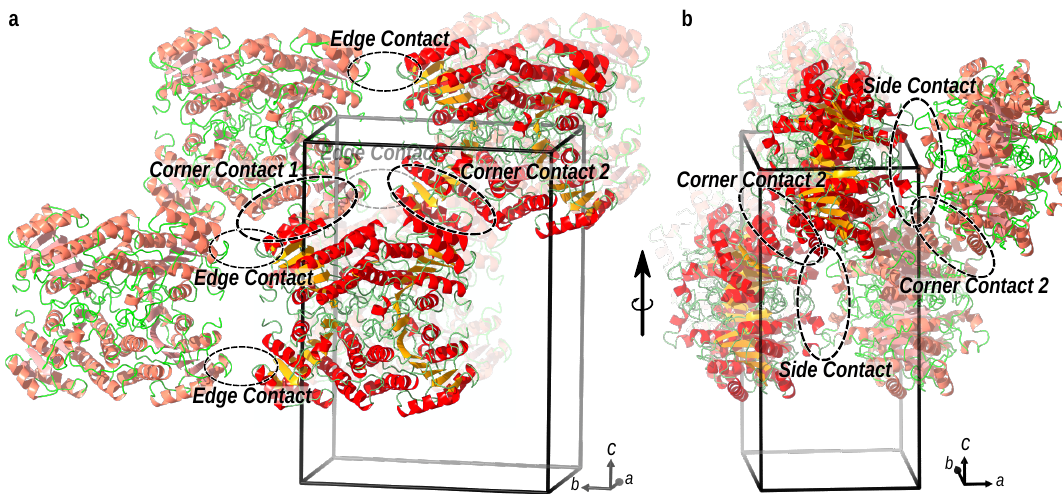
Figure 1. Crystal packing and crystallographic unit cell (UC) of Lb ADH. UC is drawn in black. The two tetramers building the UC are opaque; adjacent UCs are semi-transparent. ( a ) The view in the b - c -plane shows the “edge contact” and the “corner contacts”. In space group P 2 1 22 1 “corner contact 1” and “corner contact 2” structurally slightly differ as the two tetramers are rotated with respect to each other around the b-axis (e.g., 5 ◦ in wild type Lb ADH). In space group I 222, the two tetramers are translationally invariant and therefore the “corner contacts” coincide (see Supplementary Table S4 for an overview of Lb ADH variant space groups). ( b ) The view in the a - c -plane shows the third crystal contact: the “side contact” between two